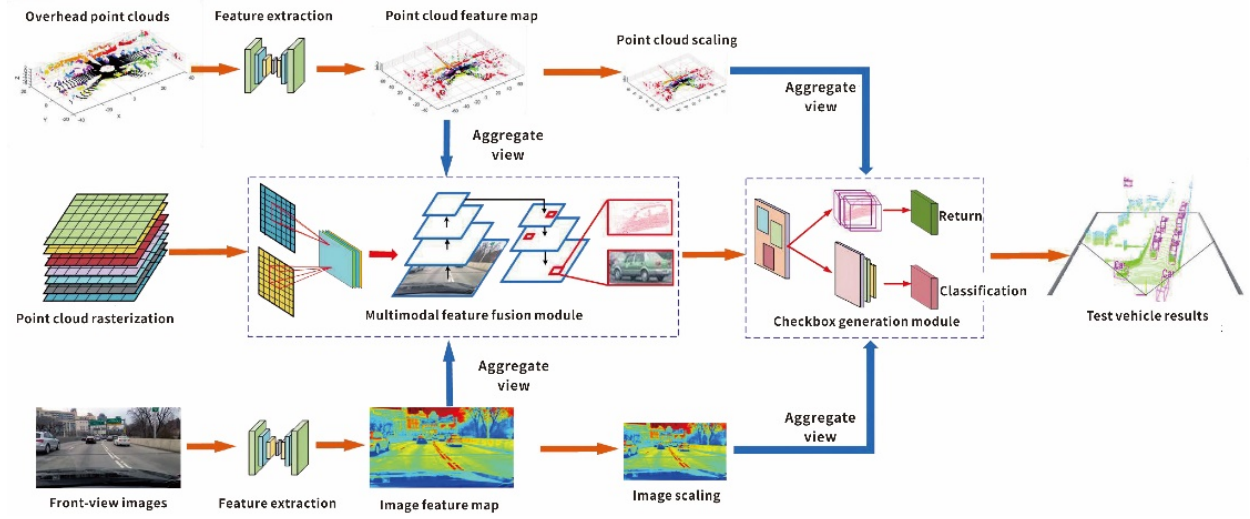
Figure 7. Algorithm framework.